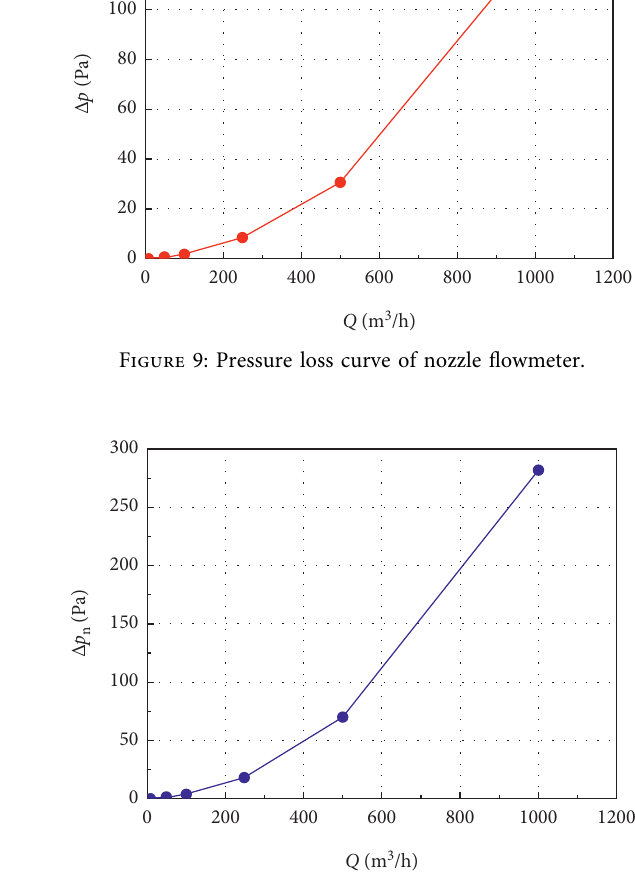
Figure 10: Pressure difference of upstream and downstream nozzle.